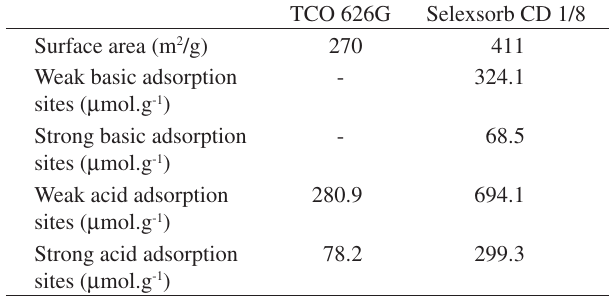
Table 2. Surface Characterization of the